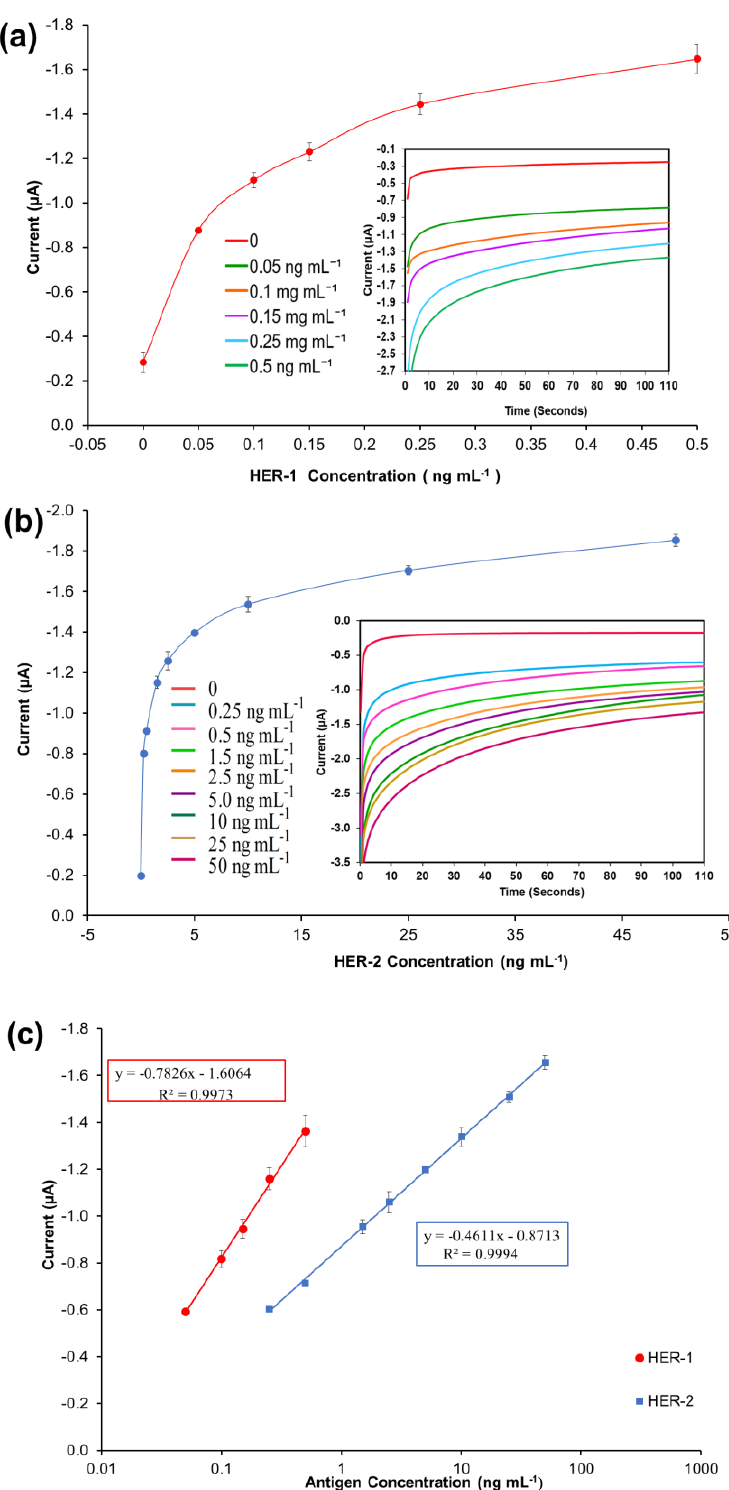
Figure 4. Biosensor response of the optimized immunoassay performed using AuNP-Ab-HRP conjugates against various concentrations of; ( a ) HER-1 antigen (0–0.5 ng mL − 1 ) and ( b ) HER-2 antigen (0–50 ng mL − 1 ). The embedded graphs show the raw data reading obtained from the chronoamperometry measurements. ( c ) Linear regression curves for HER-1 and HER-2 AuNP-Ab- HRP conjugate assay, obtained with data taken from Figure 4a,b. Standard deviations were calculated for experiments performed in triplicates ( n = 3).